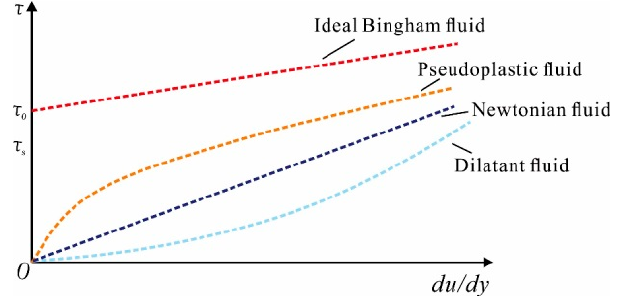
Figure 14. Flow curves of fluids.